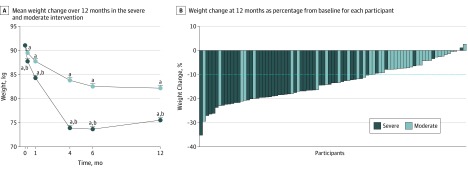
Weight Changes in Postmenopausal Women With Obesity During the Type of Energy Manipulation for Promoting Optimum Metabolic Health and Body Composition in Obesity (TEMPO) Diet Trial A, Weight data presented as estimated marginal means, ie, group means after controlling for covariates. B, Weight change at 12 months as percentage change from baseline for each participant in the severe and moderate groups. The dotted line indicates 10% weight loss. For both panels, the severe intervention included 50 participants and the moderate intervention, 51.aP < .001 vs baseline value within group.bP < .05 vs the moderate group at that point.